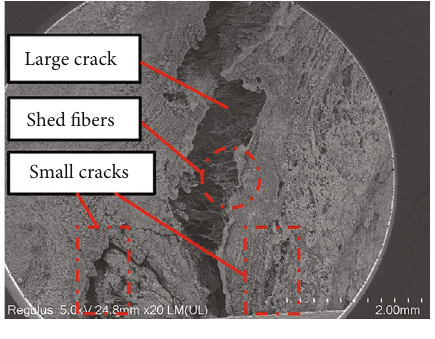
Figure 10: Insulation crack.